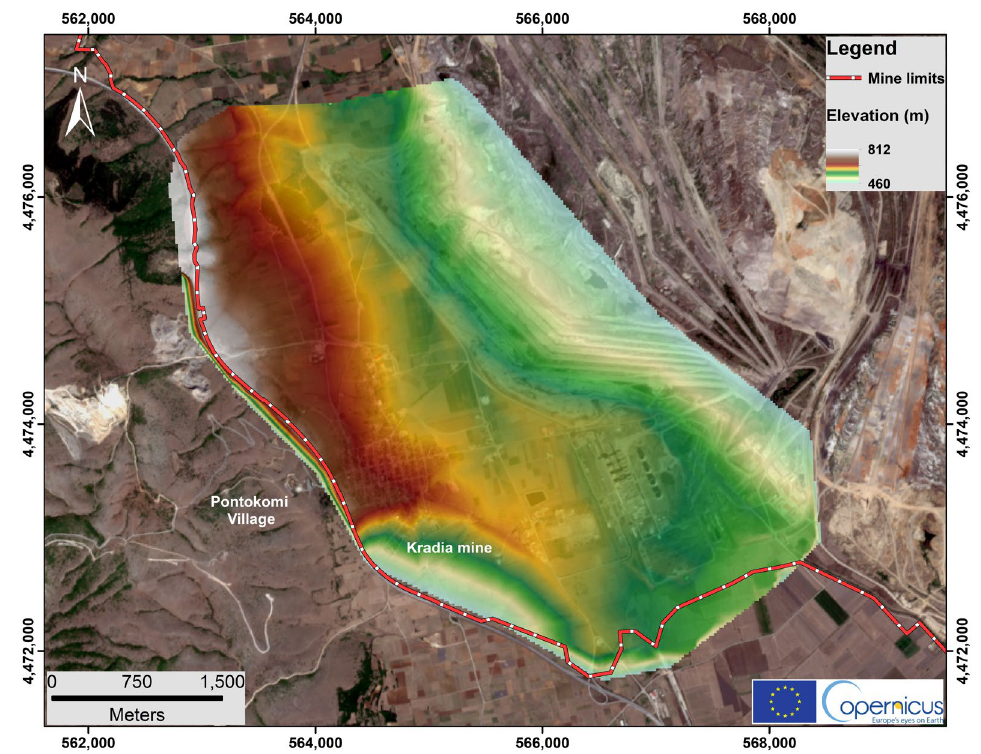
Figure 4. Digital elevation model in the broader study area of Kardia mine using ArcGIS 10.4 version. The base map is provided by the Sentinel 2b satellite European Union Copernicus program with sensing date August 31, 2021 [23].